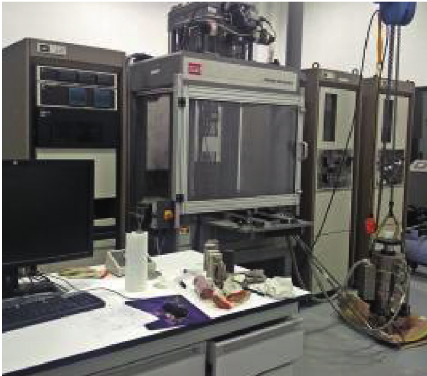
Figure 5: Servo loading system.